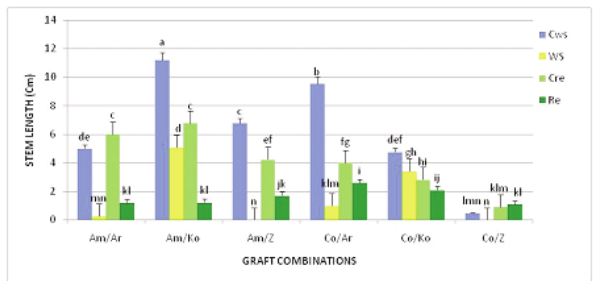
phloem).Fig. Fig. 4 - Micrographs of Am/Ko (Amygdalifolia/Koroneiki) combina- tion of olive stem (2 cm above graft union) under bright field (A, B, D) and blue fluorescence light (D). Water-stressed samples (B and D) formed narrower rings with smaller ves- sels comparing with the control (A and C) (CR= current annu- al ring, VE= vessel, PH= Fig. 5 - Micrographs of Co/Ar (Conservallia/Arbequina) combination of olive stem (2 cm above graft union) under irrigation (A and B) and water deficit conditions (C and D). The right-hand photos (B and D) were taken from samples under bright field light while A and C are the corresponding samples, respectively, under UV and blue fluorescence light, CR= current annual